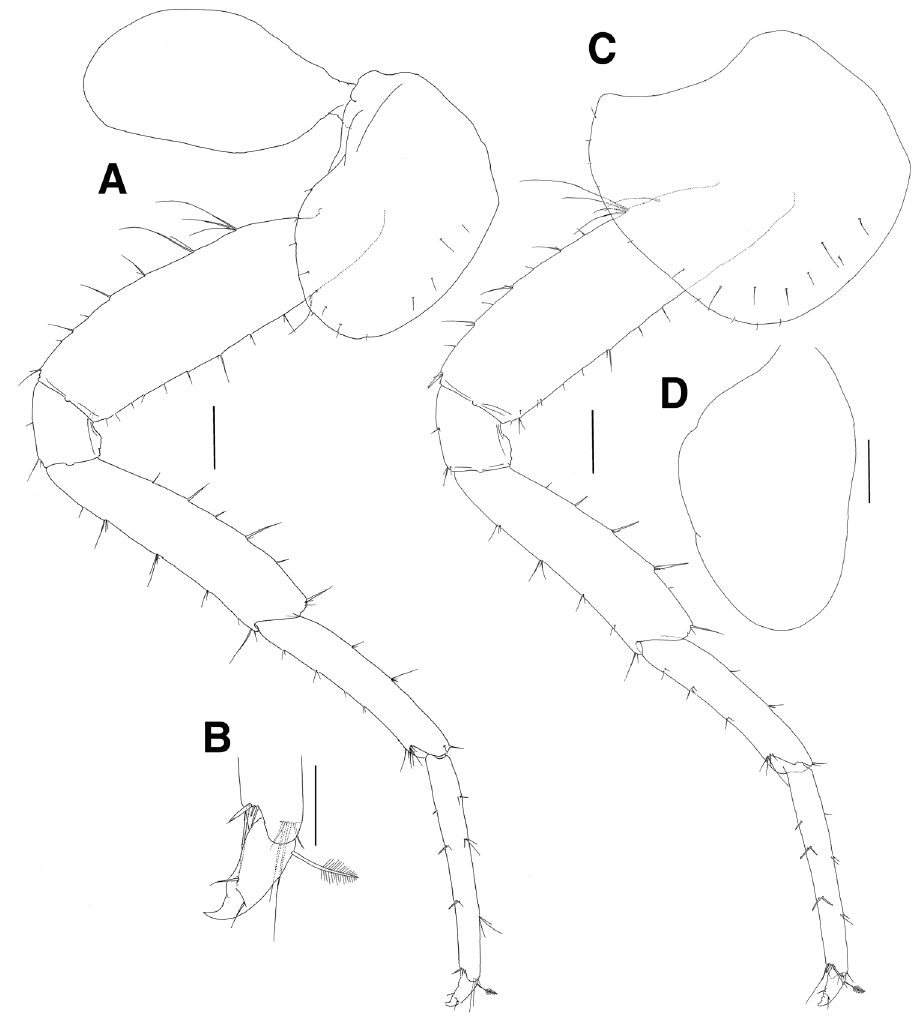
Figure 9. Paramoera dentipleurae sp. n., holotype. A Pereopod 3 B Dactylus of pereopod 3 C Pereopod 4 D Coxal gill of pereopod 4. Scale bars 0.05 mm ( B ), 0.2 mm ( A, C, D